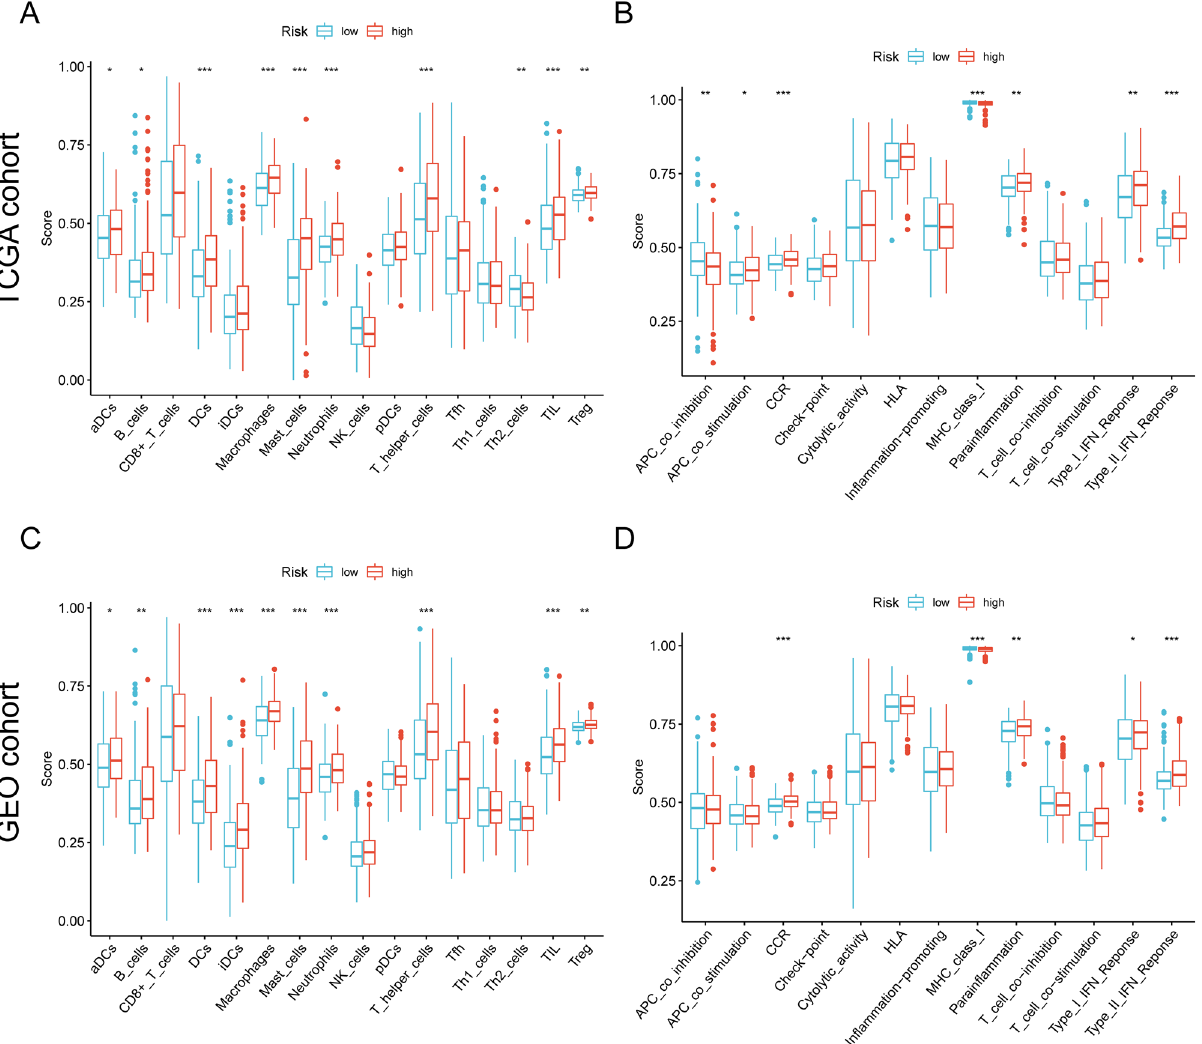
Figure 10. ssGSEA scores in the high- and low-risk group in the TCGA-GC and GSE84437 cohort. ( A , B ) TCGA cohort, ( C , D ) GSE84437 cohort. The scores of 16 immune cells ( A , C ) and 13 immune-related functions ( B , D ) are displayed in